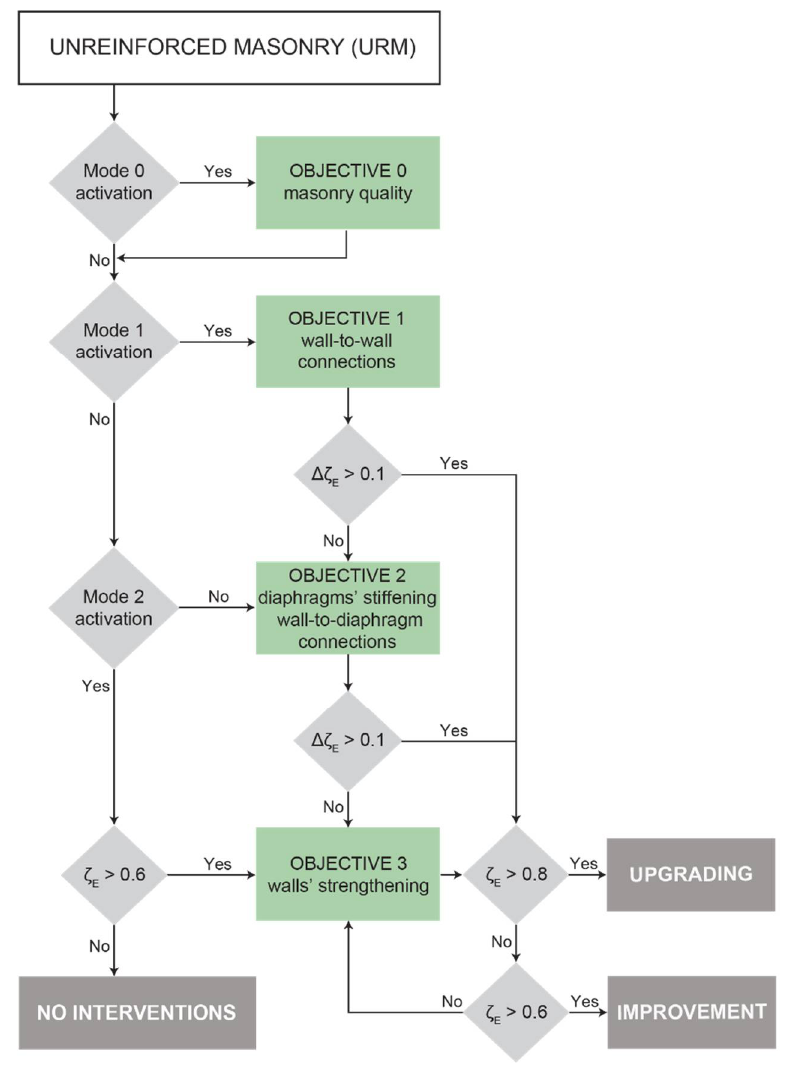
Figure 1. Incremental procedure for selection and evaluation of interventions on masonry buildings according to expected seismic